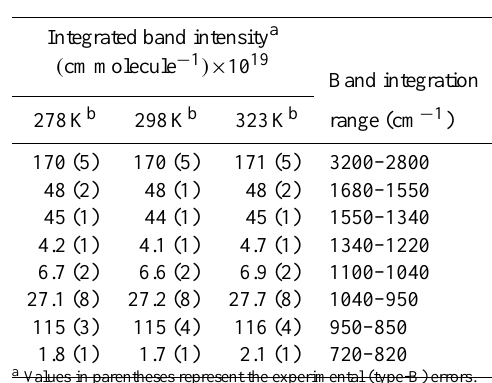
Table 5. Integrated band intensities of